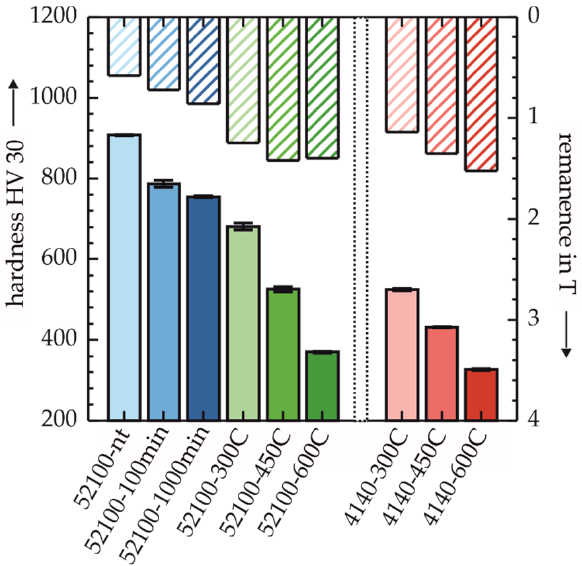
Figure 6. Comparison between hardness ( HV 30 ) and remanence determined from the magnetic hysteresis.